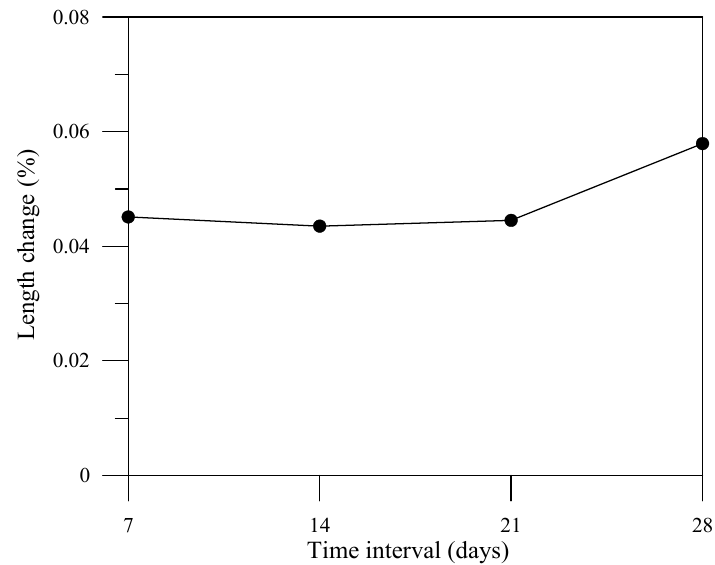
Figure 4. Length change